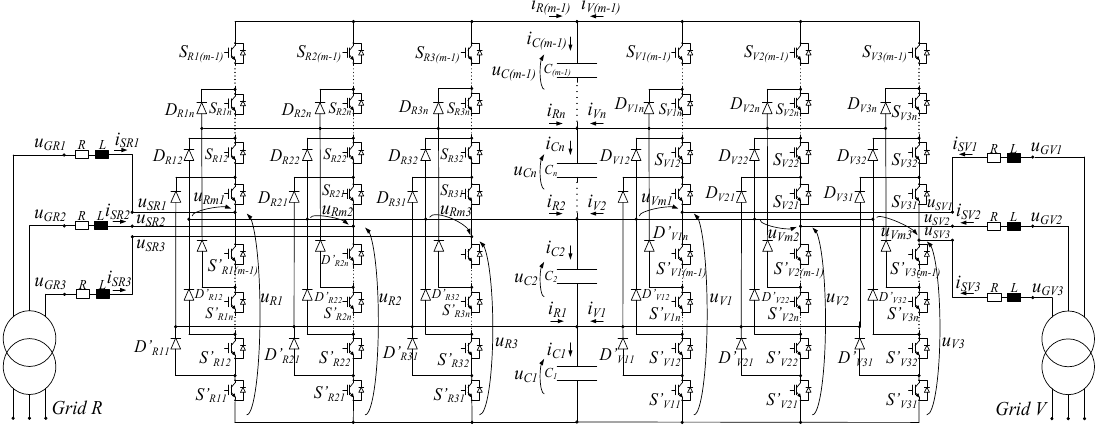
Figure 1. Multilevel NPC back-to-back connected converter.